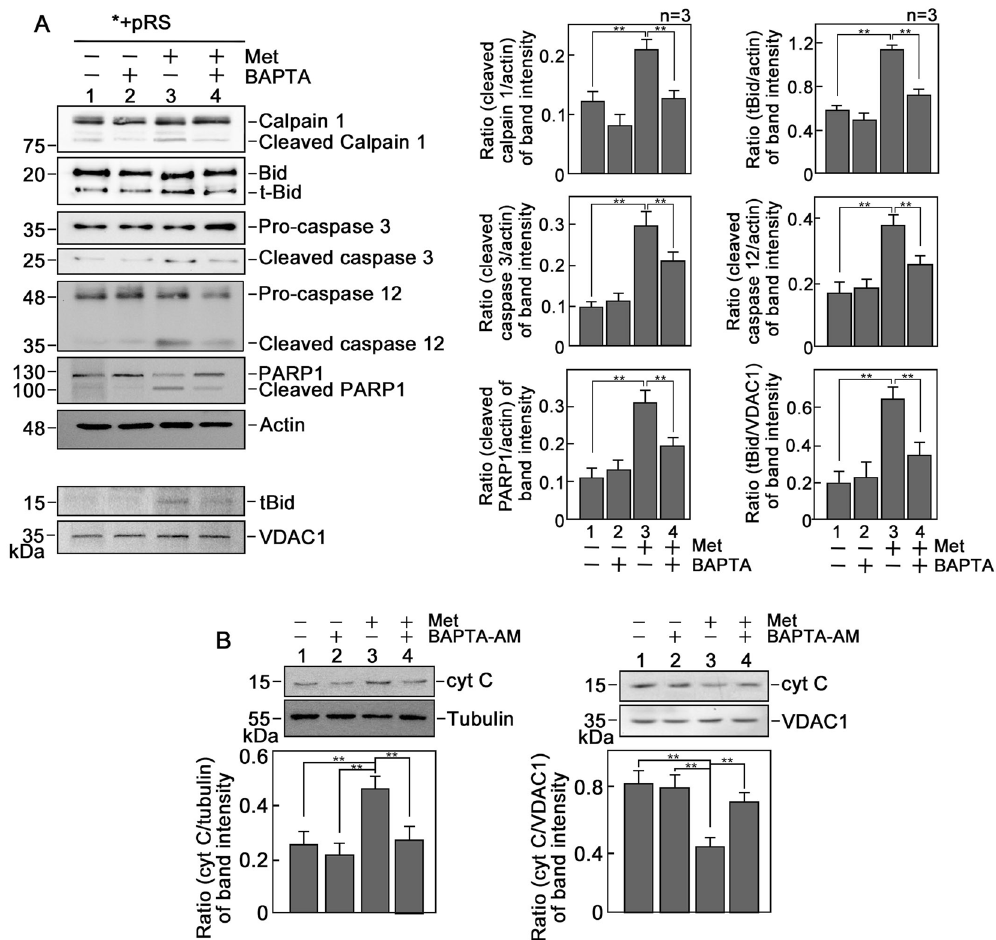
Figure 6. d,l-Methadone induces apoptosis through upregulation of the Ca 2+ -mediated calpain-1-Bid- cytochrome C-caspase-3/12 apoptotic pathway. ( A ) Lysates of cells treated with d,l-methadone in the presence or absence of BAPTA-AM for 24 h were analyzed by SDS-PAGE and immunoblotting for calpain 1, Bid, caspase-3, cleaved caspase-3, caspase-12, PARP1 and actin. Actin blot was used as loading control. Mitochondrial fractions from cells treated as described above were also analyzed by SDS-PAGE and immunoblotting for t-Bid and VDAC1. Representative blots are from one of three independent experiments (n = 3) showing similar results. Charts on the right panel show the ratios of the levels of apoptosis-associated proteins vs actin or VDAC1, with the actin and VDAC1 values normalized to 1.0. The charts correspond to the densitometry analysis of the representative blots shown on the left panel. ( B ) d,l-Methadone increases cytochrome C (cyt C) level in the cytosol. Cytosolic and mitochondrial fractions from cells pre-treated or untreated with 0.5 μM BAPTA-AM for 30 min then treated or untreated with 0.5 μg/ml d,l-methadone for 12 h were analyzed by SDS-PAGE and immunoblotting for cyt C, tubulin and VDAC1 (upper panels). Tubulin and VDAC1 were used as loading controls for cytosolic and mitochondrial fractions, respectively. Representative blots are from one of three independent experiments showing similar results. The lower panels show the ratios of cyt C vs tubulin or VDAC1 levels, with tubulin or VDAC1 levels normalized to 1.0. Values are means ± SEM of the three independent experiments (n = 3). ** p <